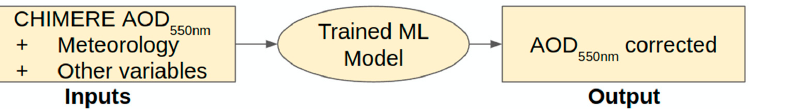
Figure 1. Flowchart showing the pixel-by-pixel approach to bias correcting CHIMERE-derived AODs.